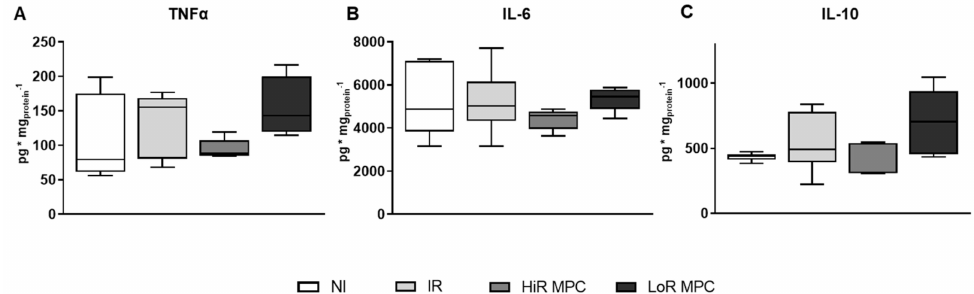
Figure 6. Cardiac cytokine content at 15 min reperfusion. ( A ) Tumor necrosis factor alpha (TNF α ); ( B ) interleukin 6 (IL-6); ( C ) interleukin 10 (IL-10). HiR, high recovery; IR, ischemia reperfusion; LoR, low recovery; MPC, mechanical postconditioning; NI, no ischemia. Data are expressed as median, 25–75 percentiles and range. ( n = 5–8 /